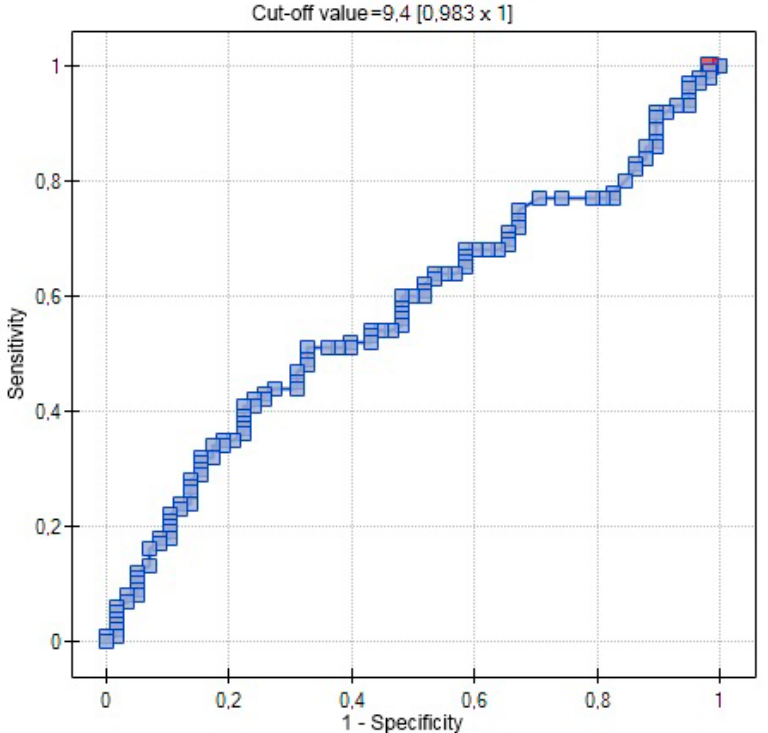
Figure 3. ROC curve-relationship between 25(OH)D concentrations (ng/mL) and occurrence of diabetes (AUC 0.5721) (red point—cut-off value).